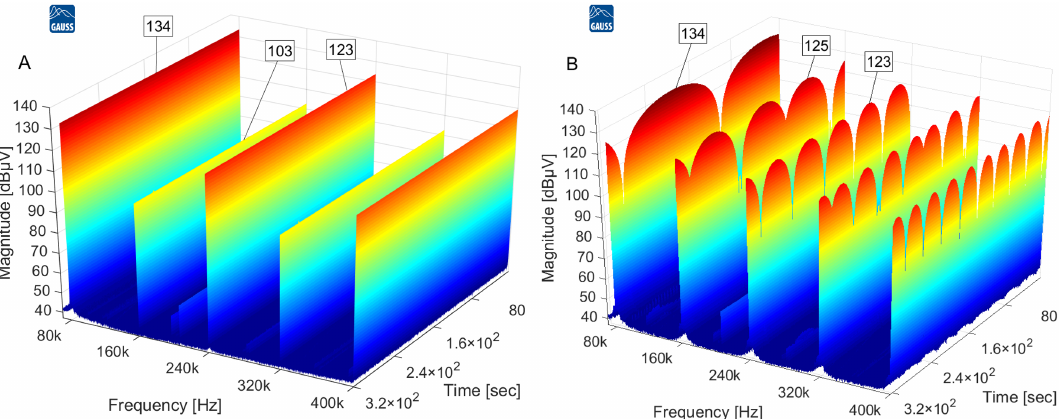
Figure 5. Experimental 3D spectrograms of interference measured using AV detector, caused by one DC/DC converter with DetM ( A ), and two DC/DC converters with DetM ( B